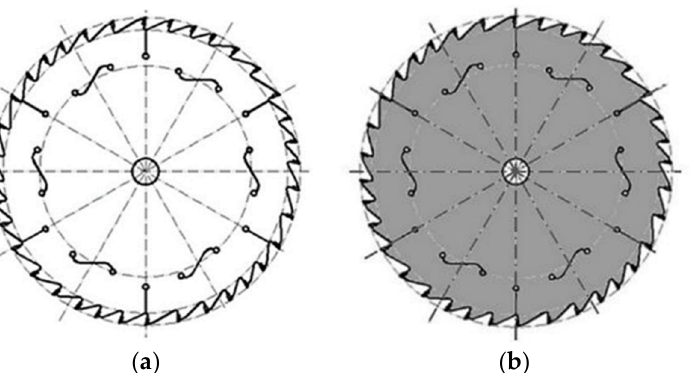
Figure 2. Circular saw blades used in the experiment: ( a ) without surface treatment; ( b ) with surface treatment.